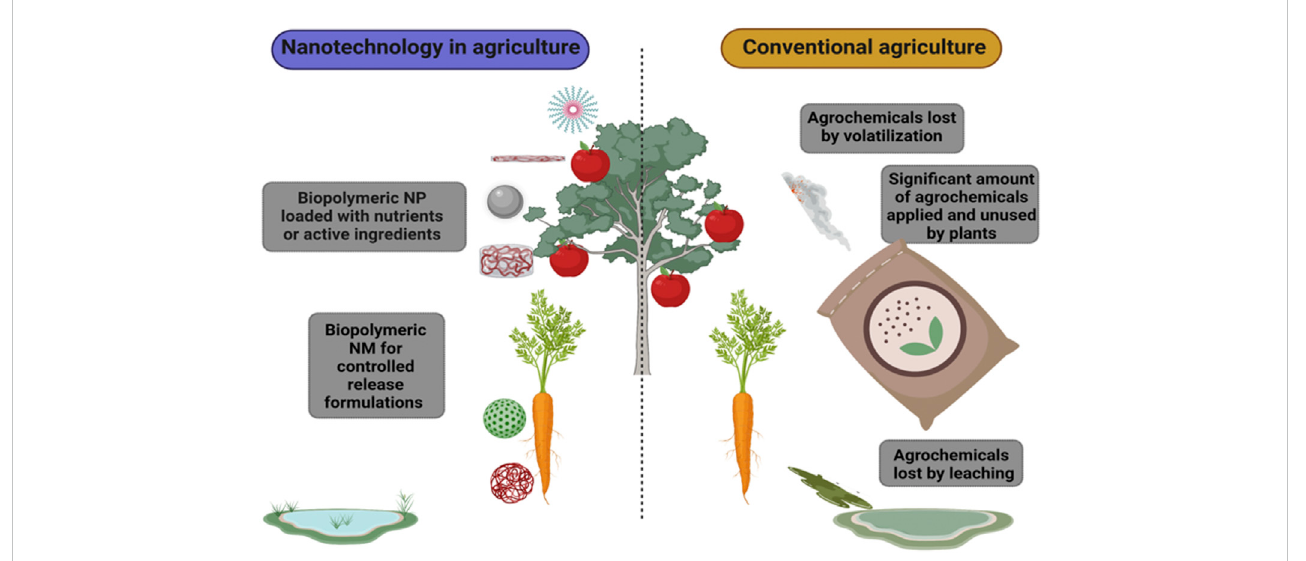
FIGURE 3 Advantages of nanotechnology in agriculture against conventional